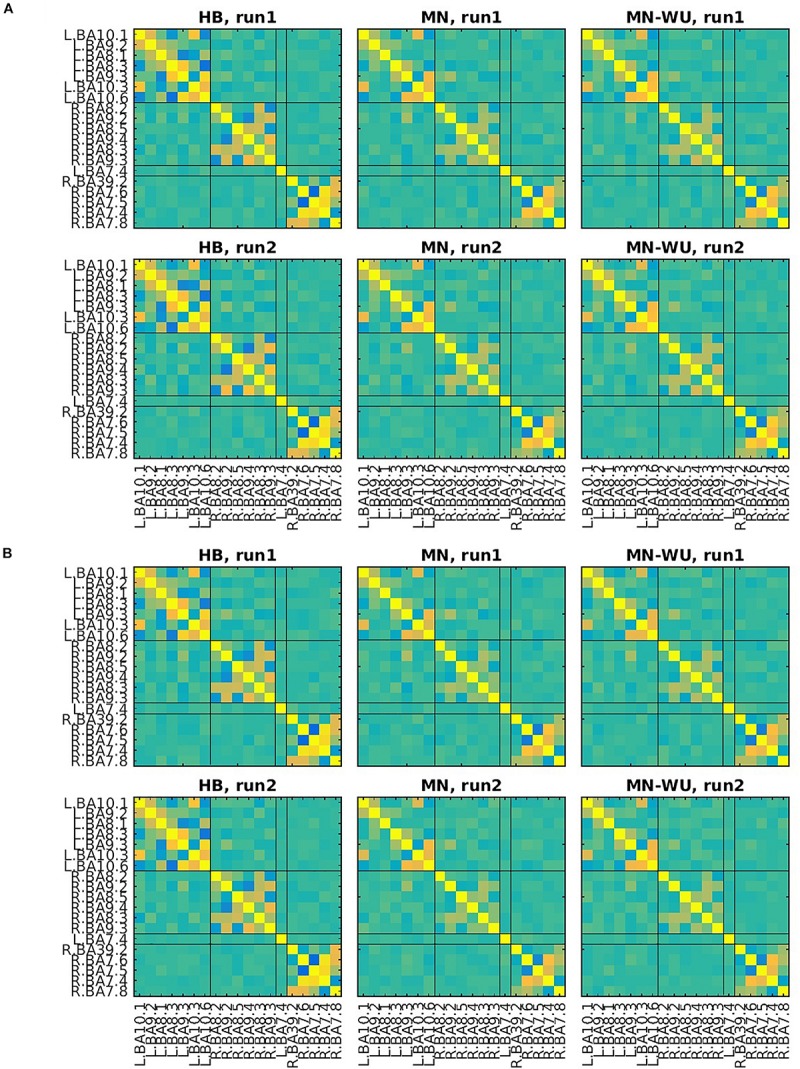
Mean maps for RSFCs are compared between run 1 and run 2. Correlation matrices are averaged across subjects for (A) oxy-Hb and (B) deoxy-Hb. The upper and lower rows correspond to run 1 and run 2, respectively. ROIs are displayed in the same order as those in Figures 4, 5.